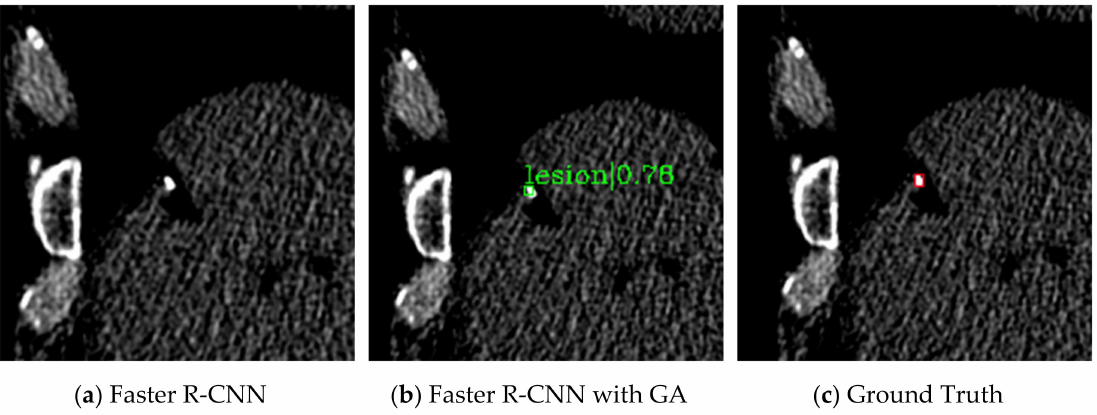
Figure 3. Missed detection of Faster R-CNN. ( a ) The detection result of Faster R-CNN. The calcified plaque is not detected. ( b ) The detection result of Faster R-CNN with guided anchoring. ( c ) The ground truth of the image. The ground truth is labeled by the red bounding box and pointed out by a red arrow.